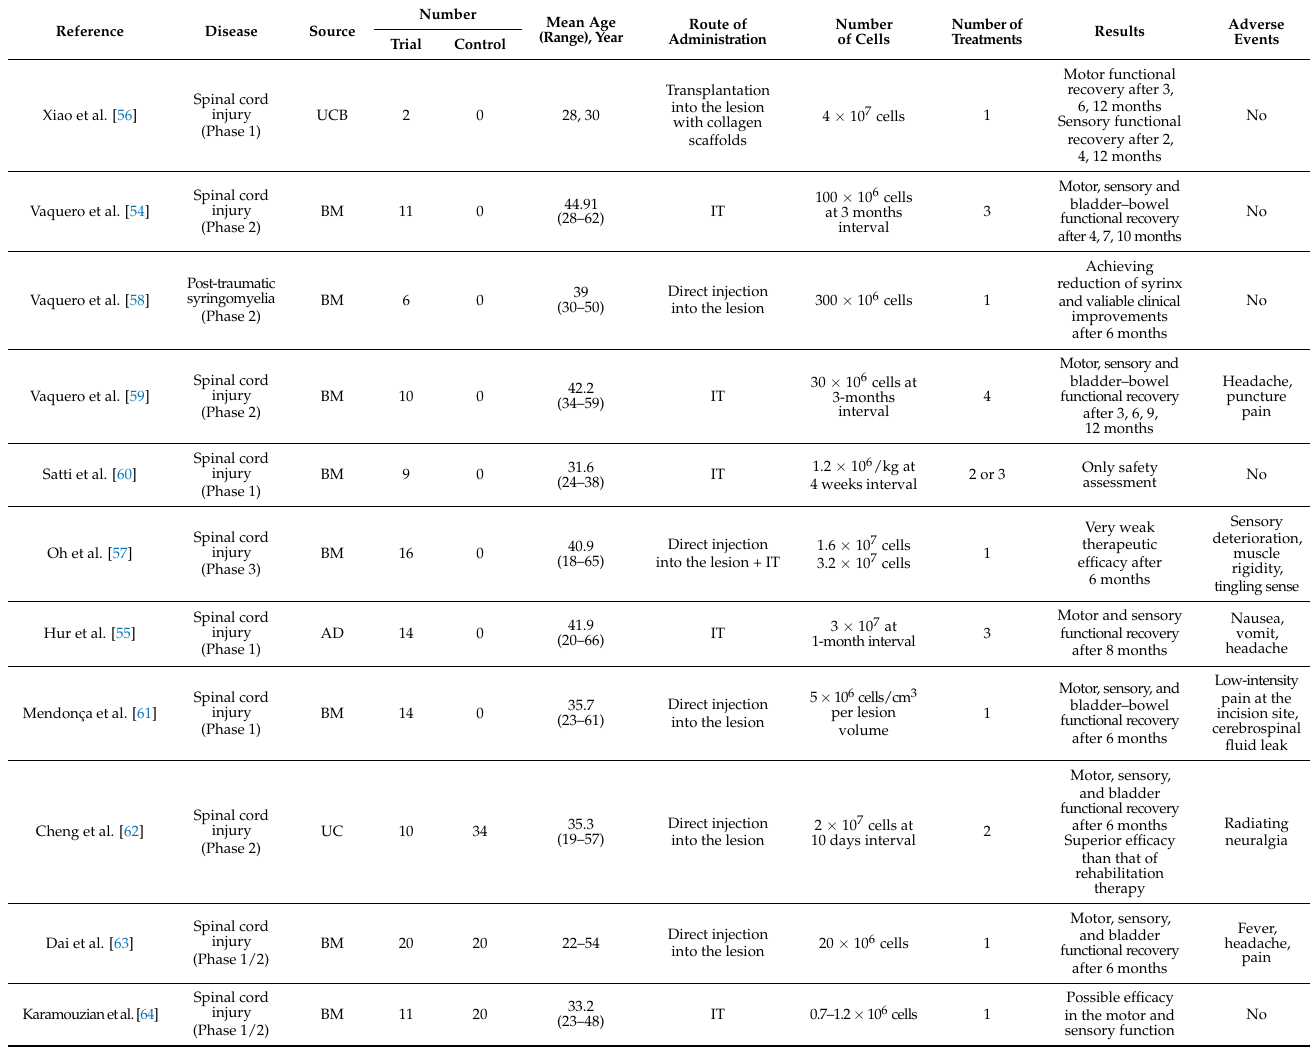
Table 2. Summary of recent clinical trials using MSCs for